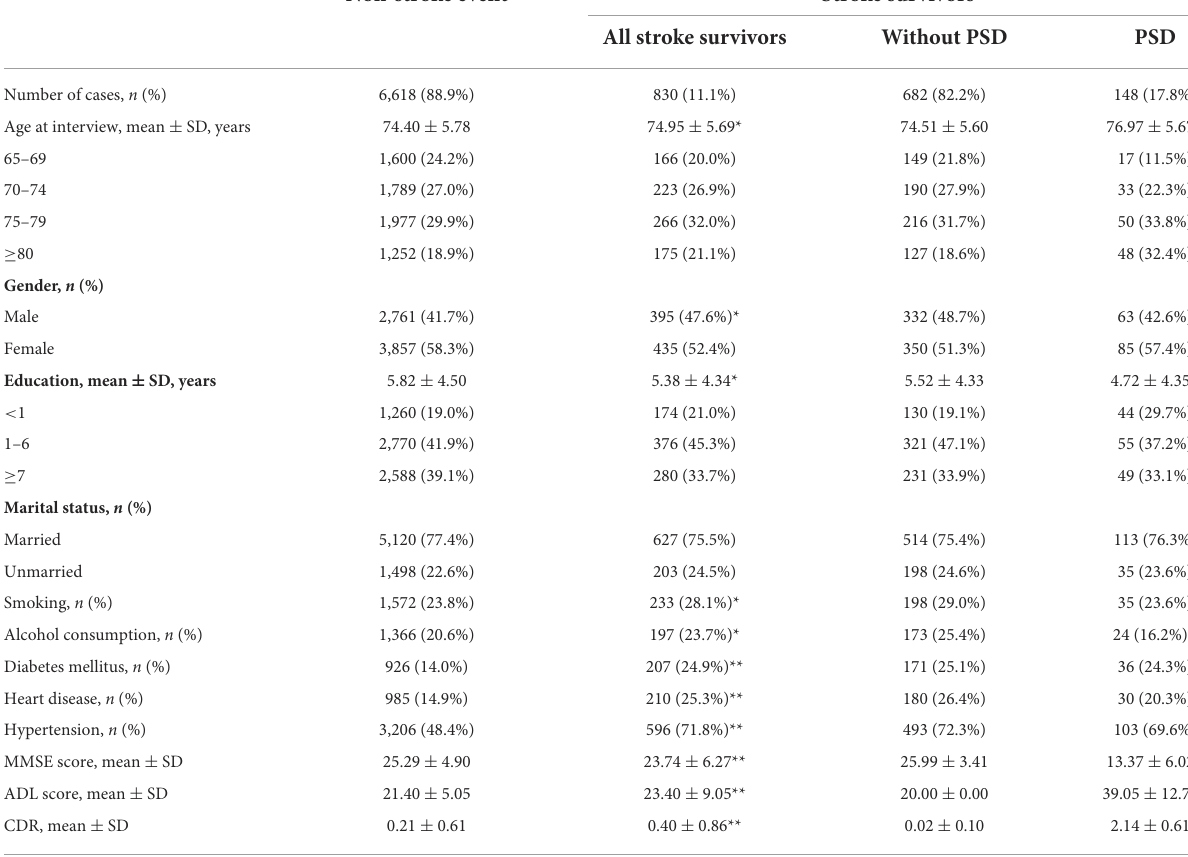
TABLE 1 Baseline characteristics and related risk factors of participants in the